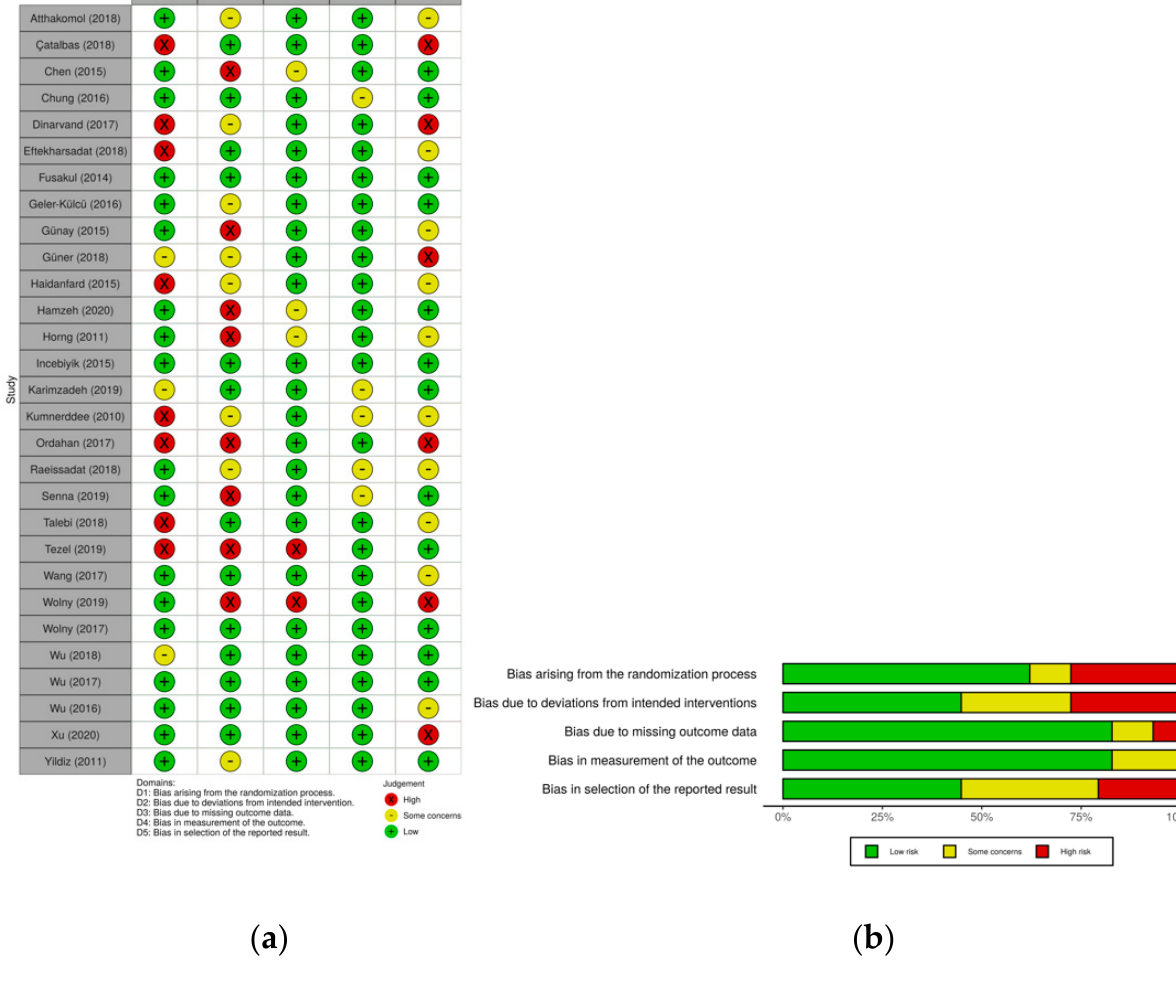
Figure 2. (a) Summary of Risk of Bias 2.0. (b) Risk of bias 2.0. graph. Figure 2. ( a ) Summary of Risk of Bias 2.0. ( b ) Risk of bias 2.0.